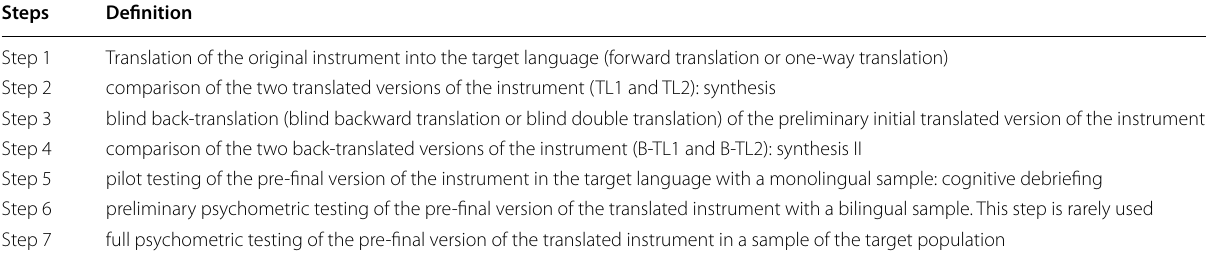
Table 1 Steps of translation, adaptation and validation of